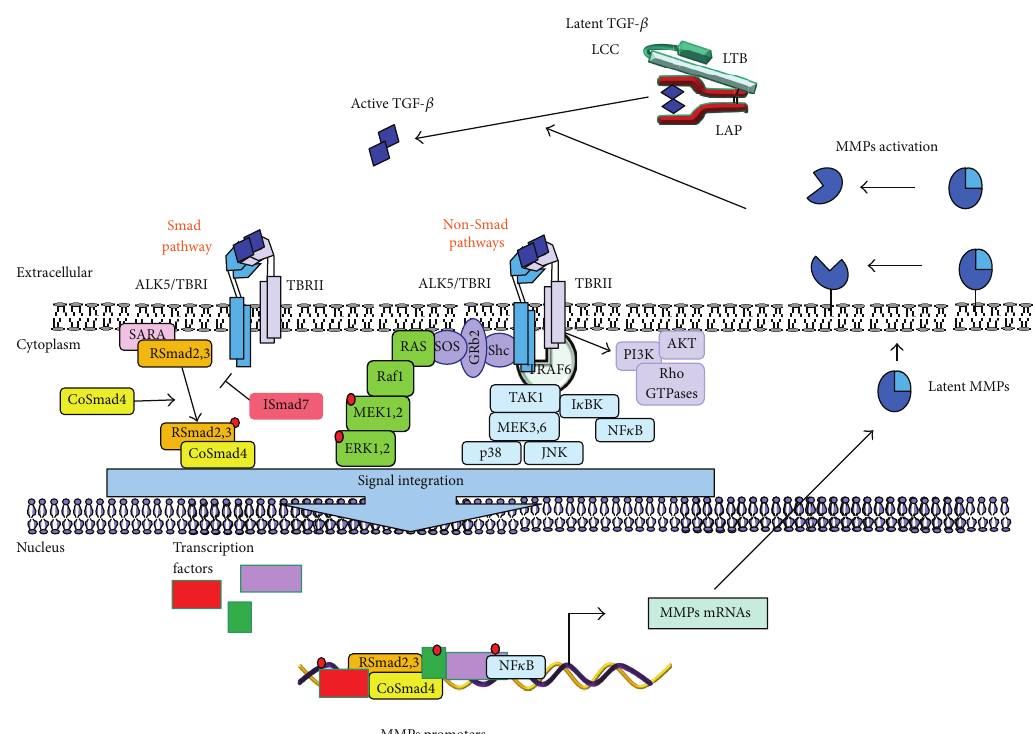
Figure 1: TGF- 𝛽 signaling and MMPs interplay. Active TGF- 𝛽 binds to its cell-surface type II receptor (TBRII), inducing the activation of TGF- 𝛽 type I receptor (ALK5 or TBRI) and forming a heterotetrameric complex. Then two sets of signaling pathways can be stimulated: the Smad pathway, where ALK5 phosphorylates Smad2,3 and promotes the release of Smads from the complex with SARA from the inner face of the plasma membrane (phosphorylated Smad2,3 interact with co-Smad4, forming a heteromeric complex to be translocated into the cell nucleus) and non-Smad pathways, where active TGF- 𝛽 -receptor complex interacts with ubiquitin ligase tumor necrosis factor receptor- associated factor 6 (TRAF6) which in turn recruits TGF- 𝛽 activated kinase 1 (TAK1) to activate p38, JNK, or NF 𝜅 B pathway. On the other hand, TGF- 𝛽 binding provokes the phosphorylation of ALK5 at tyrosine residues which enable the formation of Shc-Grb2/SoS complex to activate Ras-Raf1-MEK1,2-ERK1,2 signaling. Finally, receptor activated complexes can activate PI3K, provoking the activation of AKT and the small Rho GTPases. The activation of both Smad and non-Smad signaling pathways in turn initiate transcriptional or nontranscriptional activity to regulate MMPs expression, thus incrementing the protein levels in tumor microenvironment. When membrane bound MMPs or soluble MMPs are expressed, they may promote the activation of latent TGF- 𝛽 by proteolytic cleavage within the N-terminal region of the latency-associated peptide (LAP) or the large latent complex